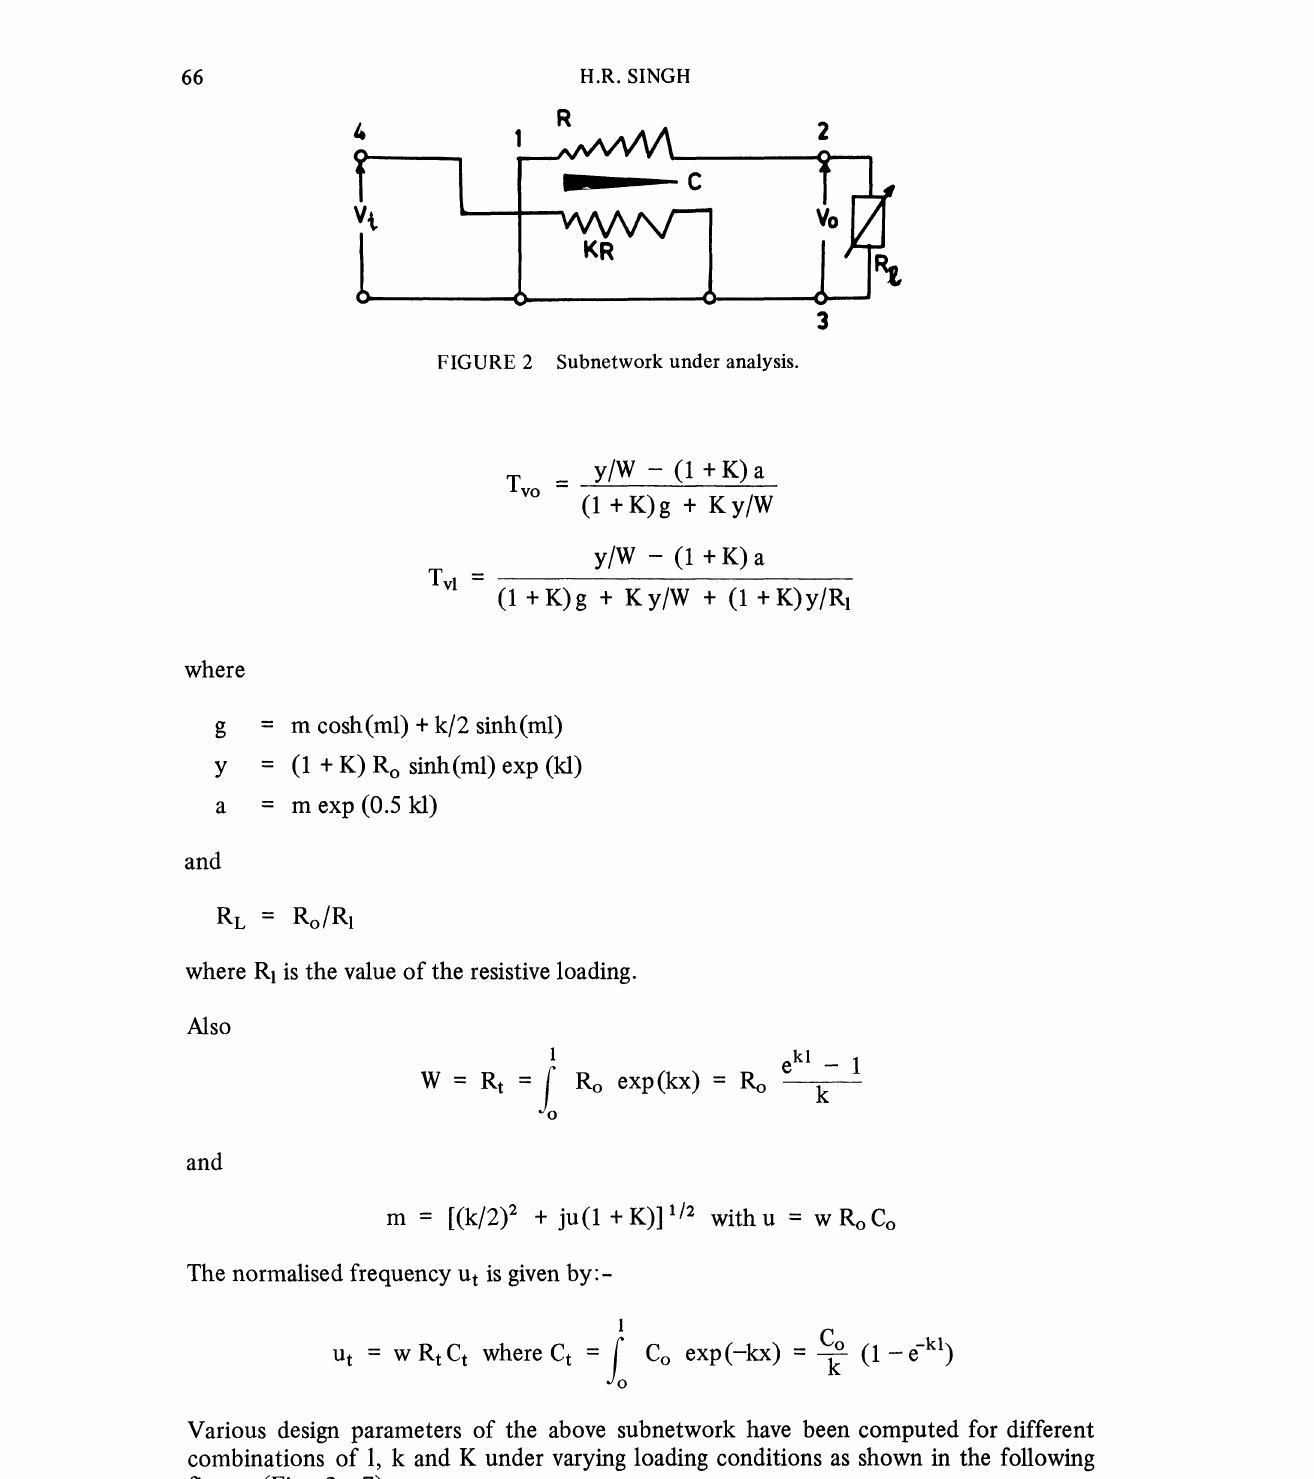
FIGURE 2 Subnetwork under